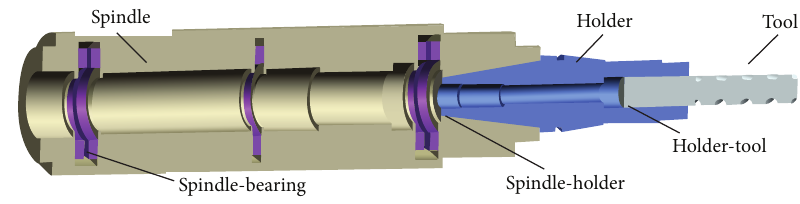
Figure 3: The cutaway view of spindle